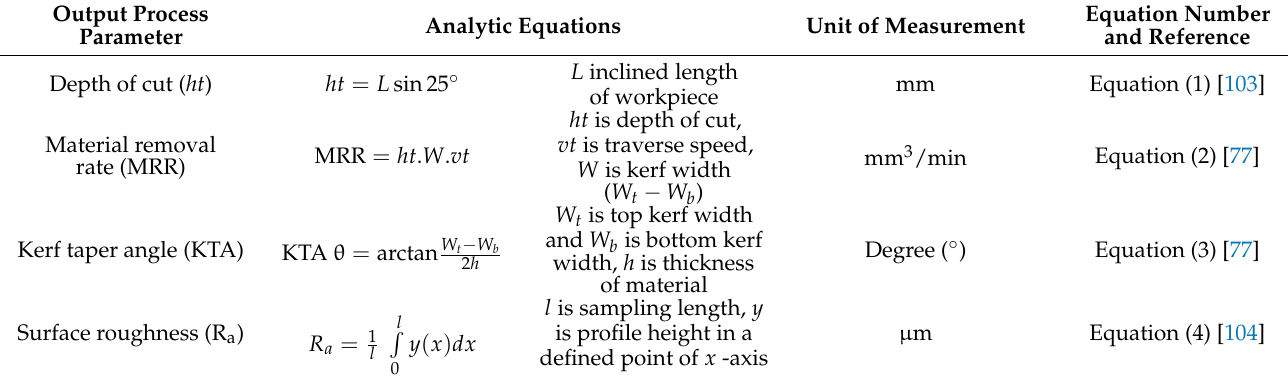
Table 7. Output process parameters analytic